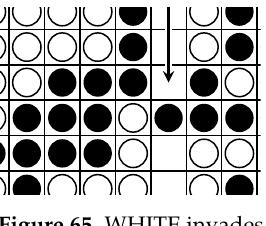
Figure 65. WHITE invades.